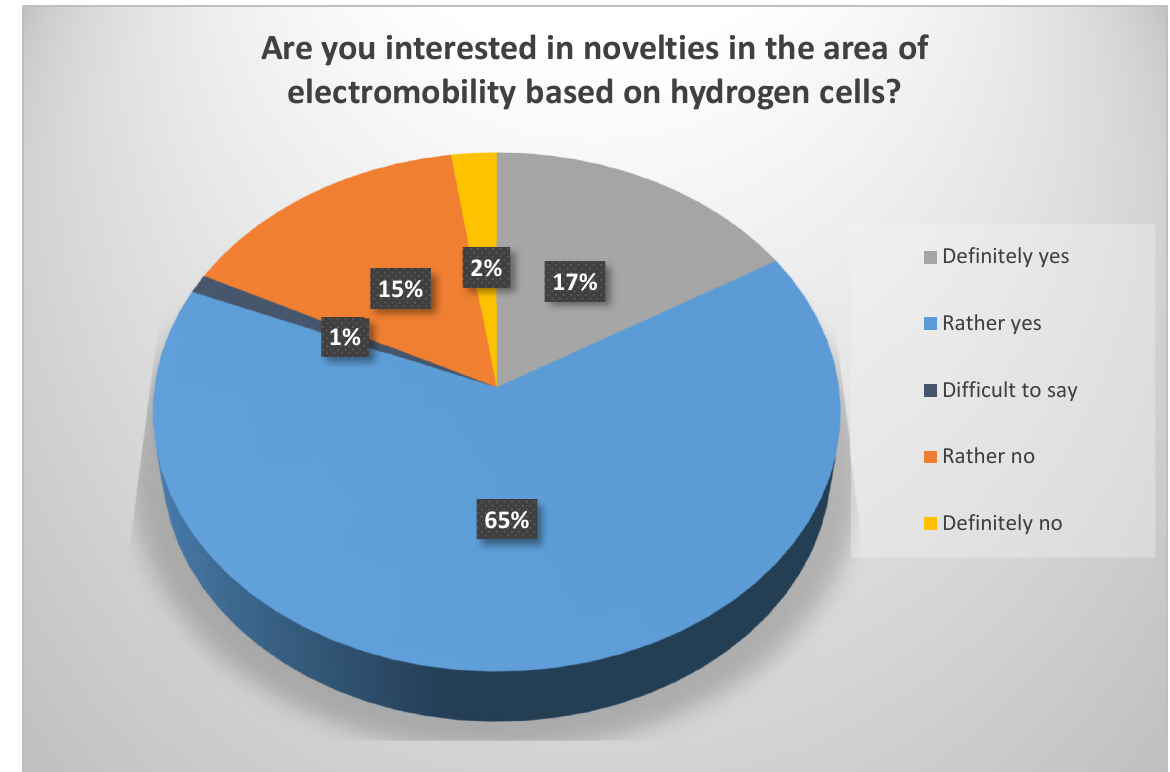
Figure 1. Survey question number 1. Source: own study.